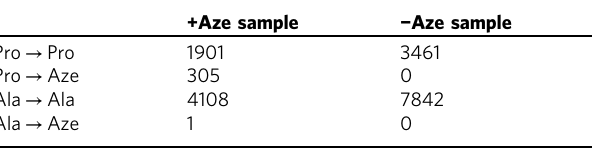
Table 2 Summary of Aze misincorporation into mammalian cell puri fi ed MBP, in Pro and Ala